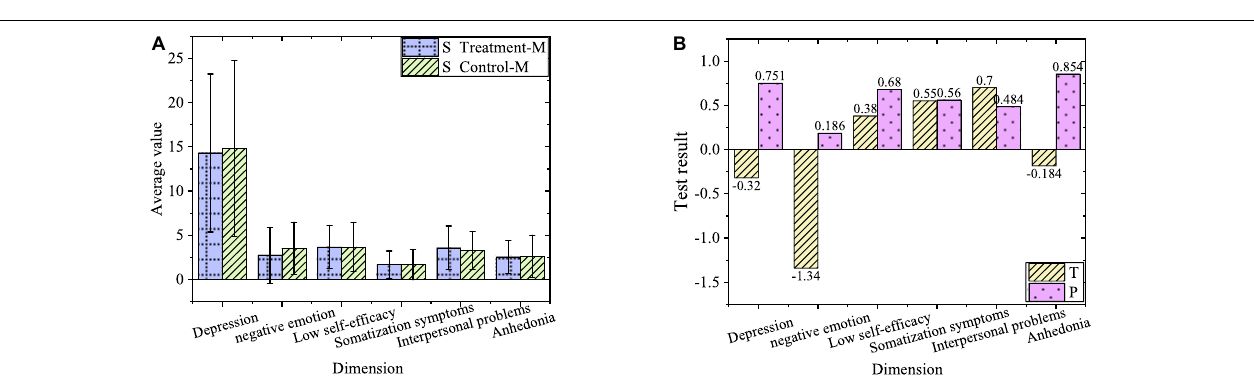
FIGURE 1 | Basic information of subjects. (A) Gender distribution. (B) Grade distribution.